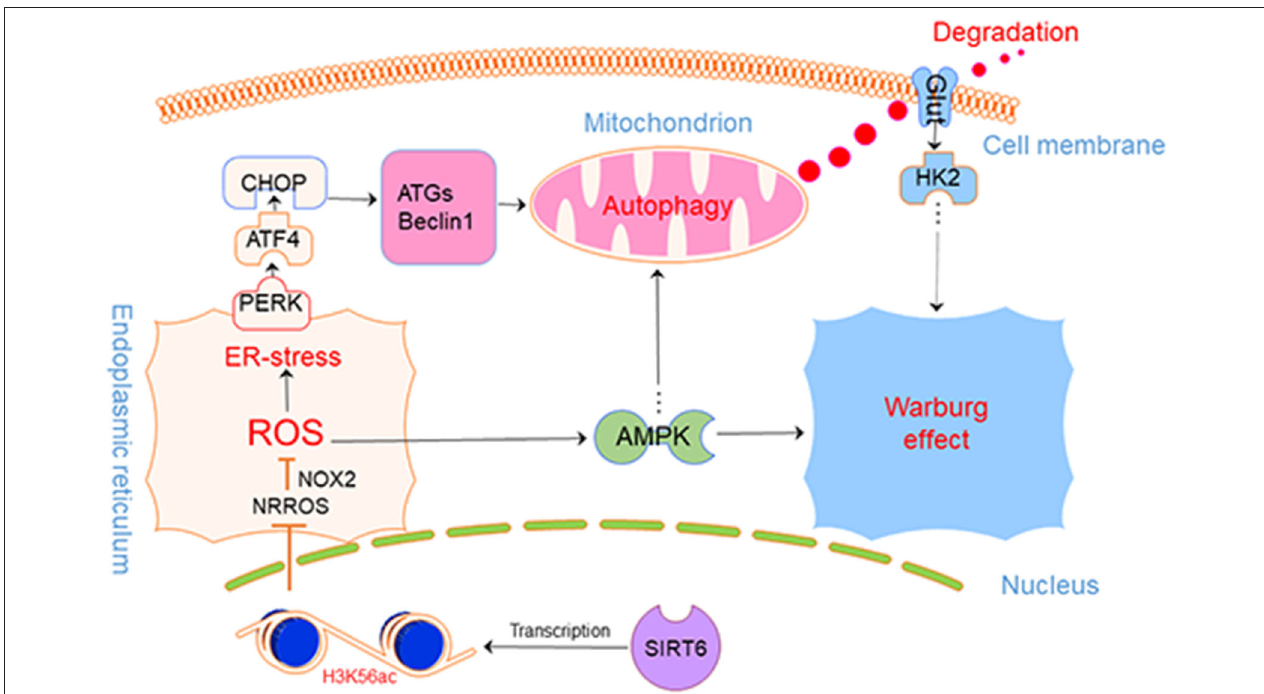
FIGURE 7 | SIRT6-Autophagy-Warburg effect axis in PTC.